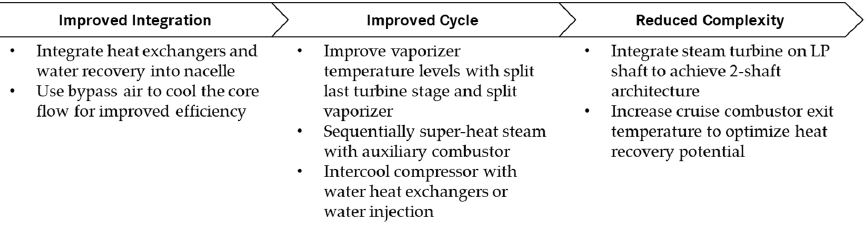
water or steam injection was